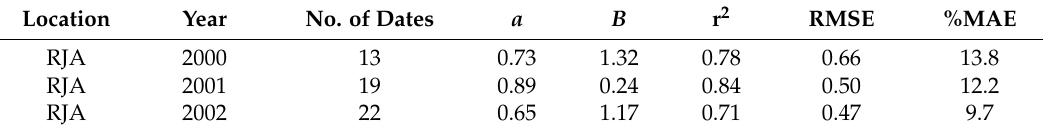
Table 5. Relationships between simulated daily ET by METRIC with flux tower derived ET.